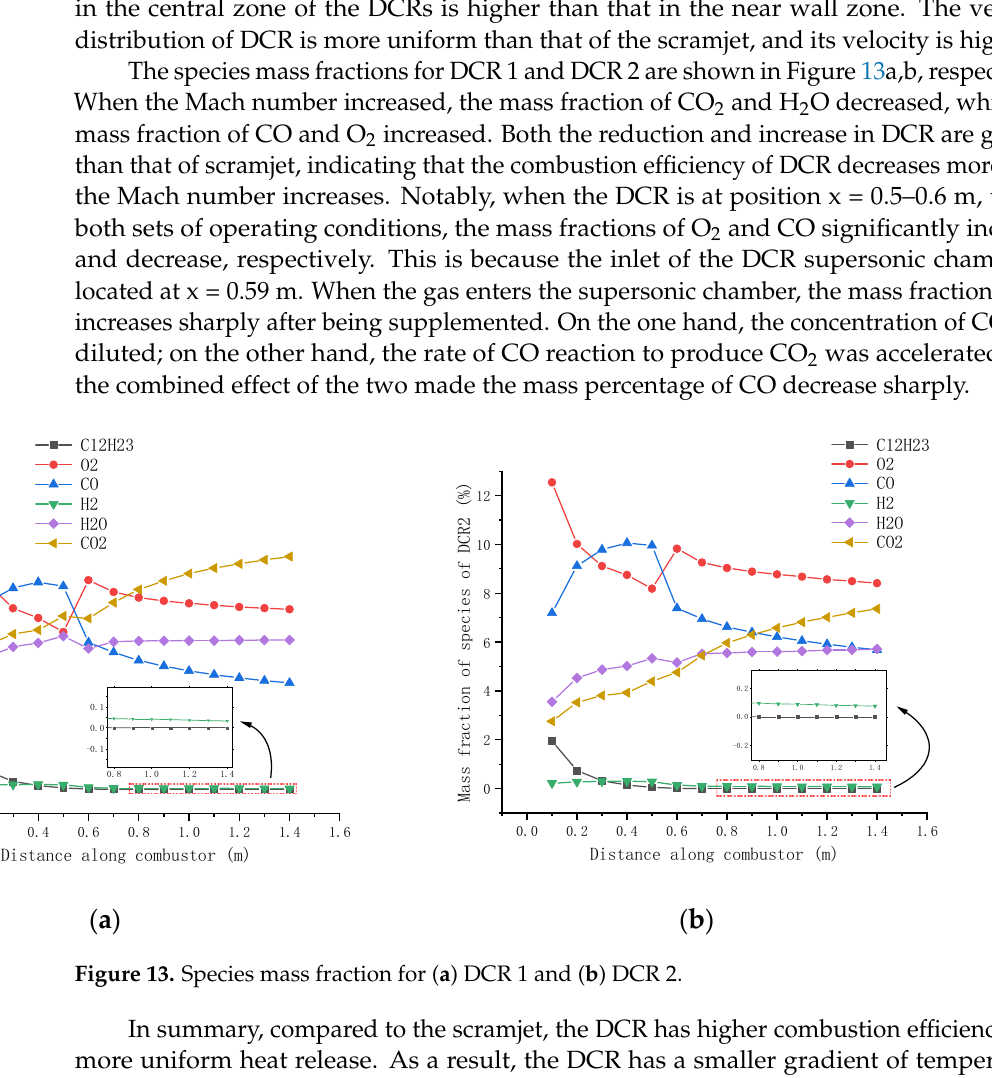
Figure 12. Velocity magnitude contours for DCR 1 and DCR 2.